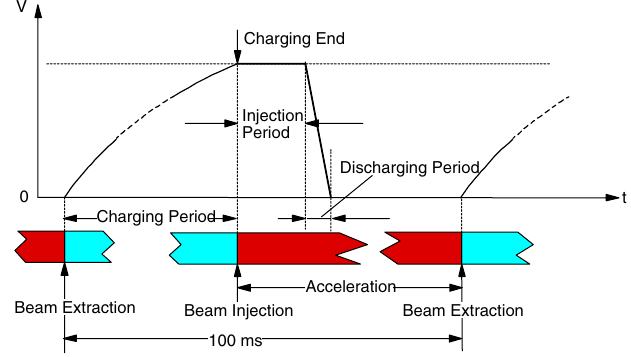
FIG. 4. Timing chart of ES-Kicker